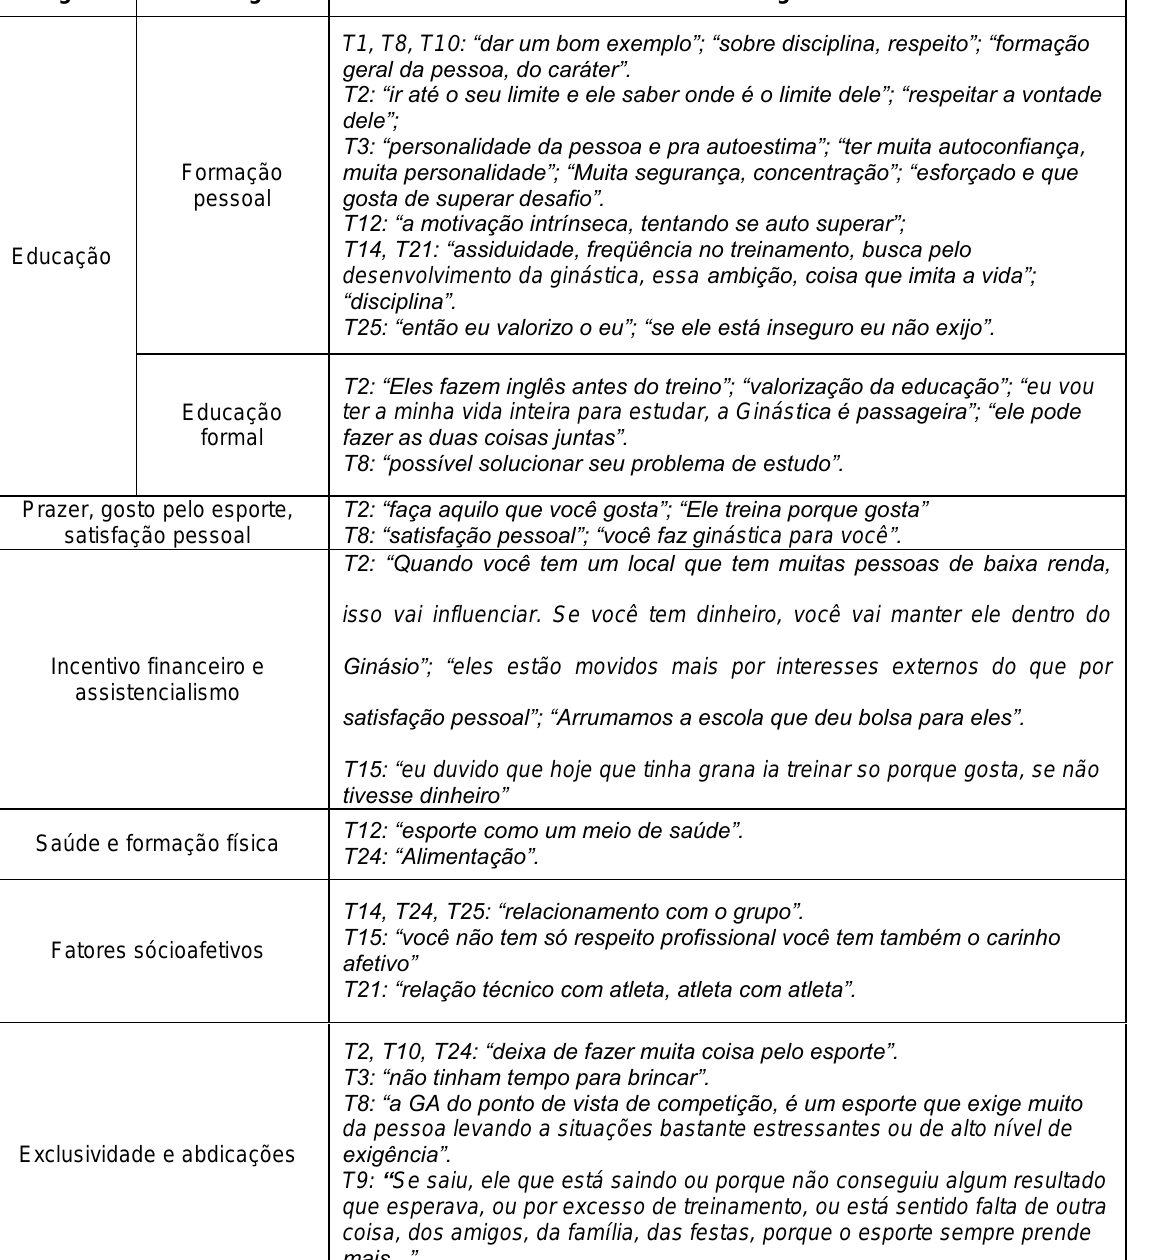
Tabela 2. Síntese dos resultados do setor